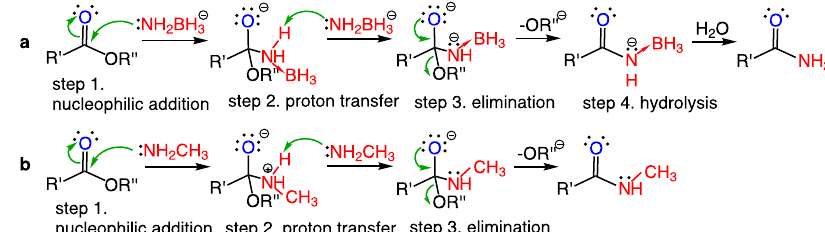
Fig. 5 The proposed mechanism of the formation of amides by the reaction of esters with NaAB (a) and with amines (b). The both reaction including the nucleophilic addition, proton transfer, and elimination in which the molar ratio of NaAB or amine to ester (R ’ , R ” = alkyl, aryl) is 2:1, however, the reaction with NaAB is fast while the reaction with amine is